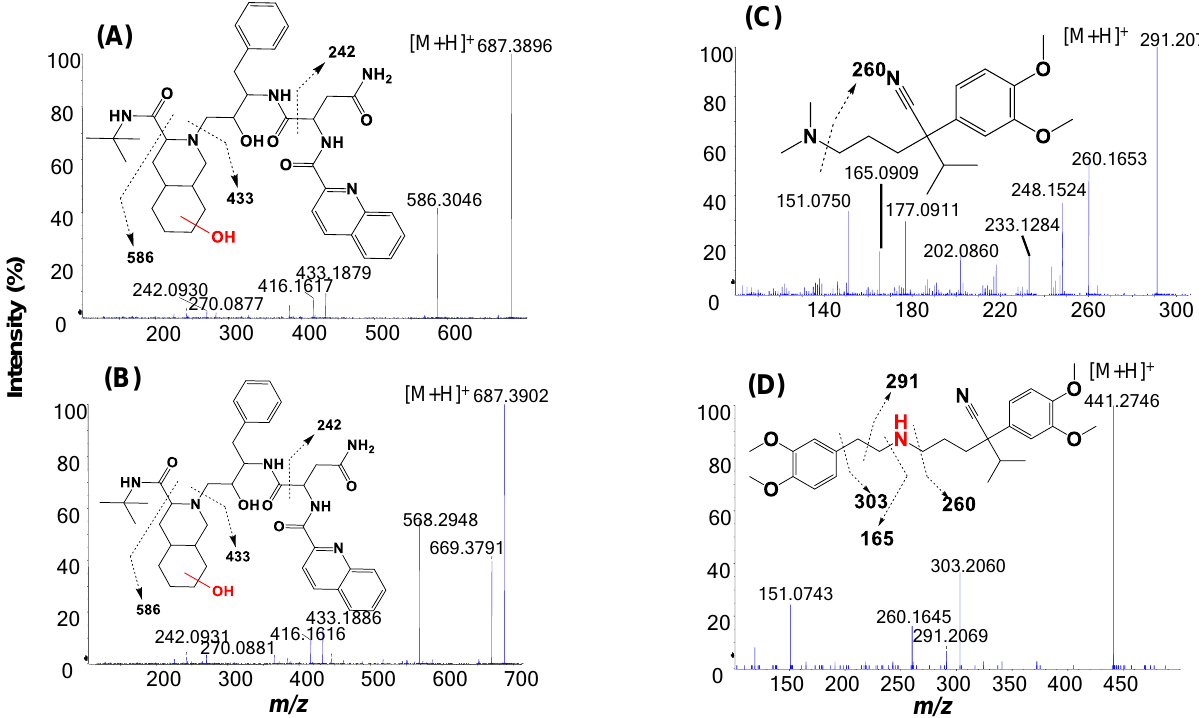
Figure 4. MS/MS spectra of saquinavir and verapamil major metabolites acquired by LC/Q-TOF; ( A ) saquinavir metabolite, S6, ( B ) saquinavir metabolites, S7, ( C ) verapamil metabolite, V1, and ( D ) ve- rapamil metabolite, V5.